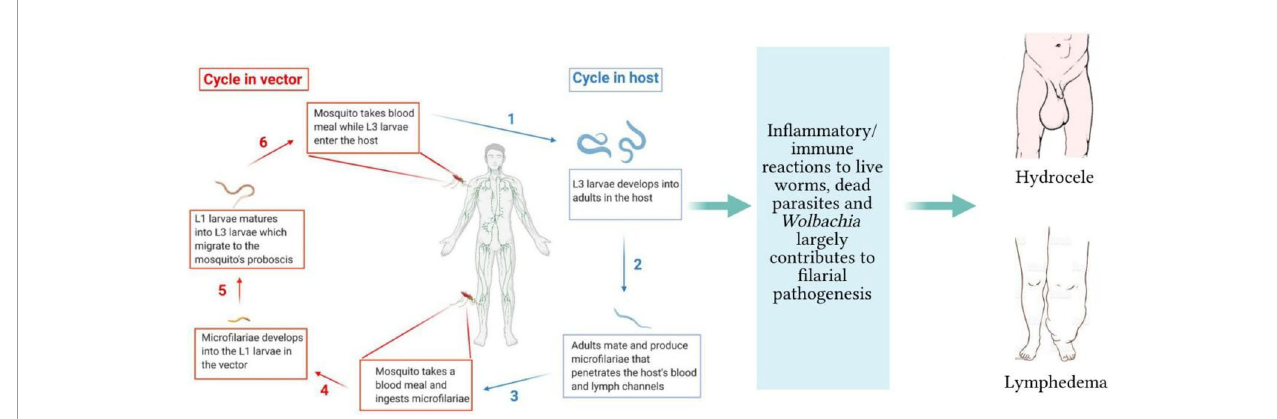
FIGURE 1 | Life-cycle of fi larial parasites demonstrated with W. bancrofti and the associated fi larial pathologies. (1) The vector transmits the infective-stage larvae into the human when taking a blood meal. (2) The L3 mature into adult worms, which produce micro fi lariae (3). They migrate to the lymphatics and blood for circulation. (4) The vector again takes up the micro fi lariae during a blood meal on an infected host. (5) The micro fi lariae develop into the L1 stage. (6) The L1 larvae mature into L3 larvae, which migrate to the vector ’ s proboscis via the haemocoel. (1) The infected vector transmits the infective-stage larvae into the human host during a blood meal. While in the host, in fl ammatory responses to live/dead parasites and immuno-regulatory mechanisms contribute to lymphedema and